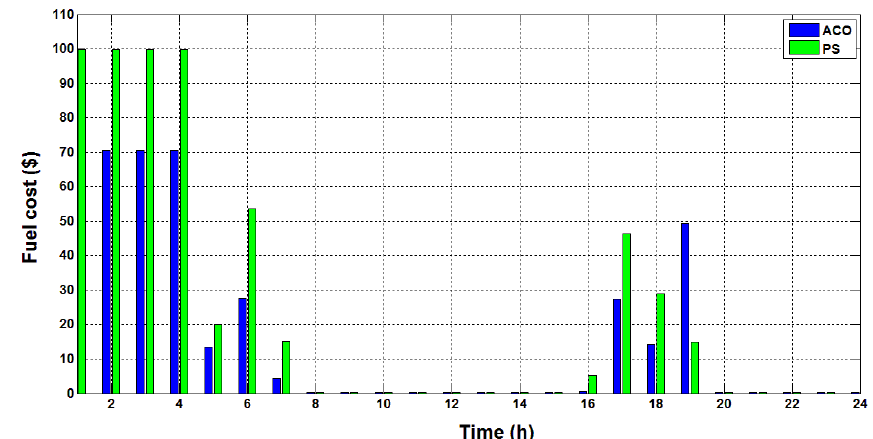
Figure 9. Pattern search PS-based EMS solution.